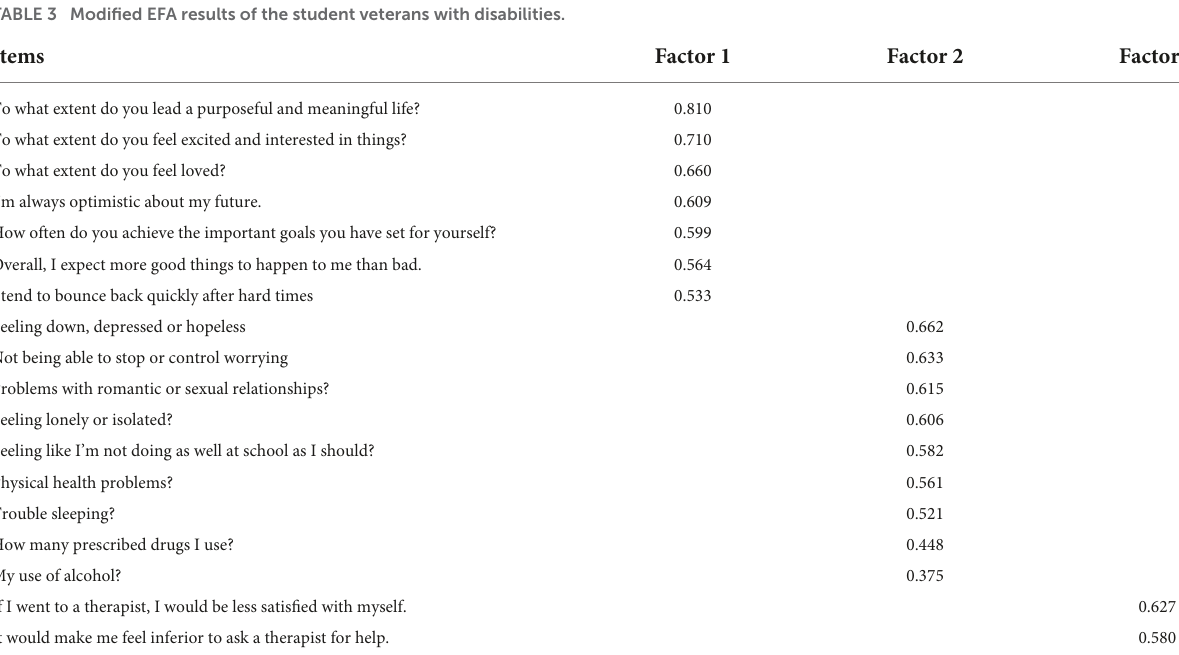
FIGURE1 Parallel analysis results.